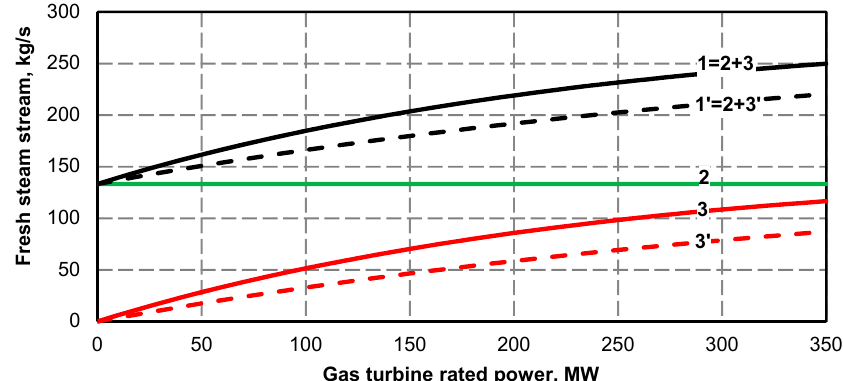
Figure 13. Fresh steam streams as a function of gas turbine rated power at a minimum steam boiler output of 133.3 kg/s: 1, 1’ — steam streams fed to the steam turbine, 2 — steam stream generated in the steam boiler at its minimum output, 3 — steam stream generated in the recovery boiler for gas turbine operating at its rated power, 3’ — steam stream generated in the recovery boiler for gas turbine operating at 60% of its rated power.